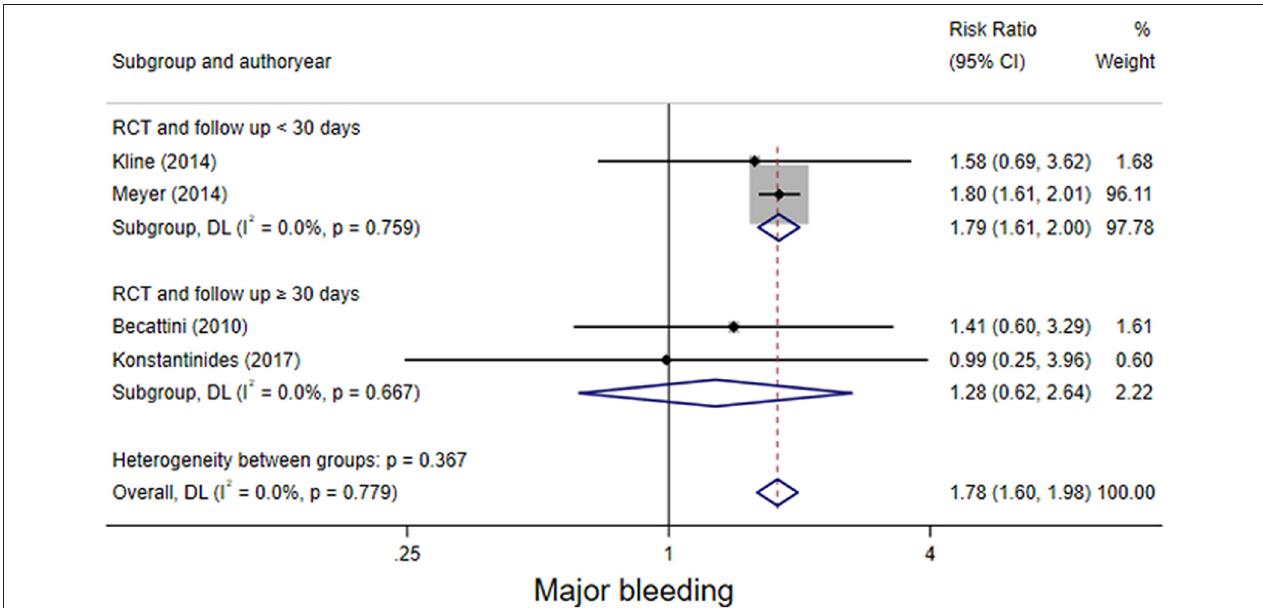
FIGURE 3 | Forest plots of tenecteplase vs. anticoagulation treatment grouped by hemorrhage rates ( < 30 days or ≥ 30 days) for patients with intermediate-risk